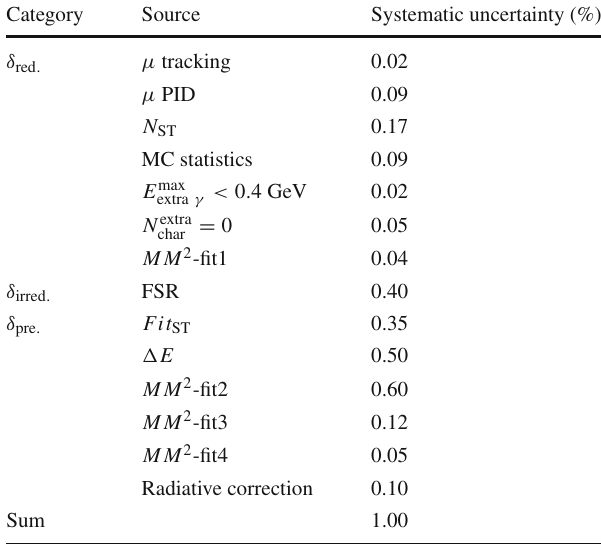
Table 1 Summarize of the systematic uncertainty in D + s → μ + ν